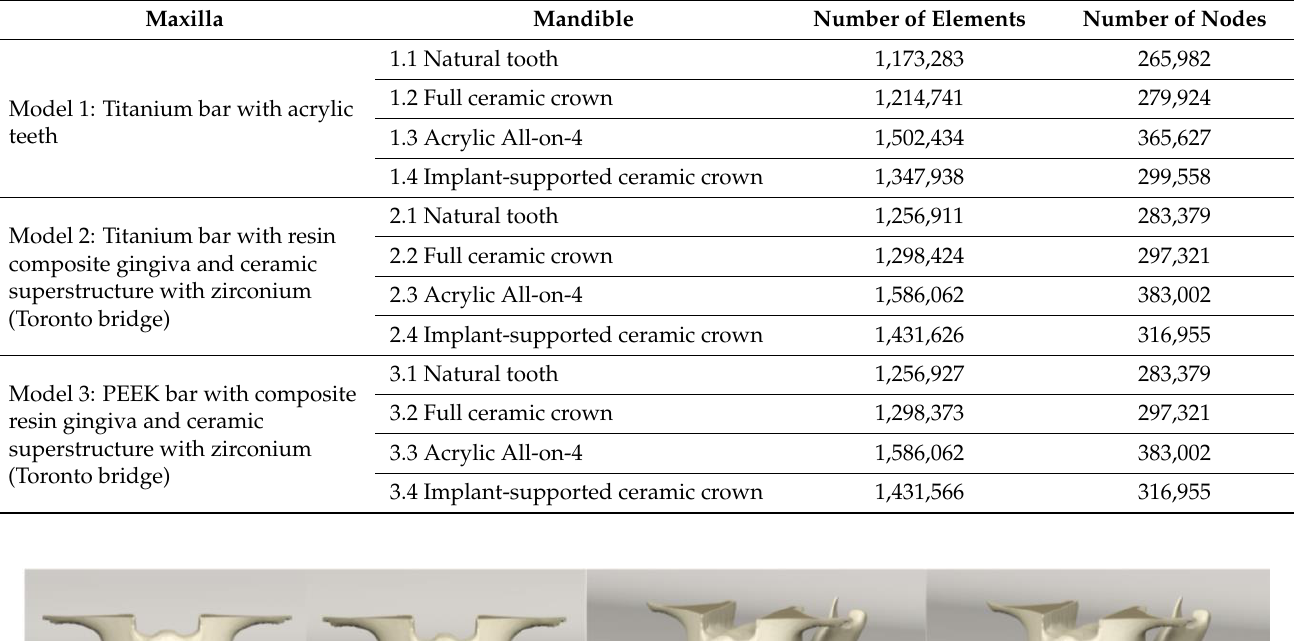
Table 1. Element and node numbers of maxillary and mandibular models.